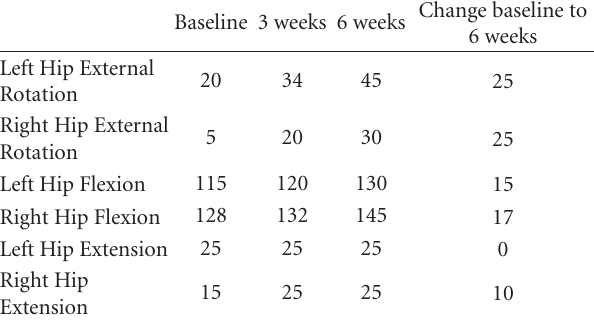
Table 1: Joint range of motion (degrees) at baseline, 3 weeks, and 6 weeks of an individual post breast cancer and necrotizing fasciitis while receiving manual therapy, soft tissue mobilization, and